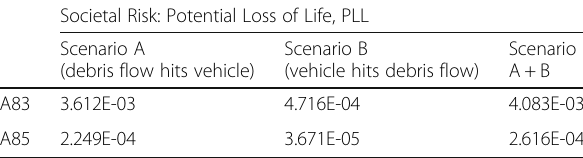
Table 3 Societal risk in terms of the PLL (50 mile/h vehicle speed) Societal Risk: Potential Loss of Life, PLL Scenario A (debris flow hits